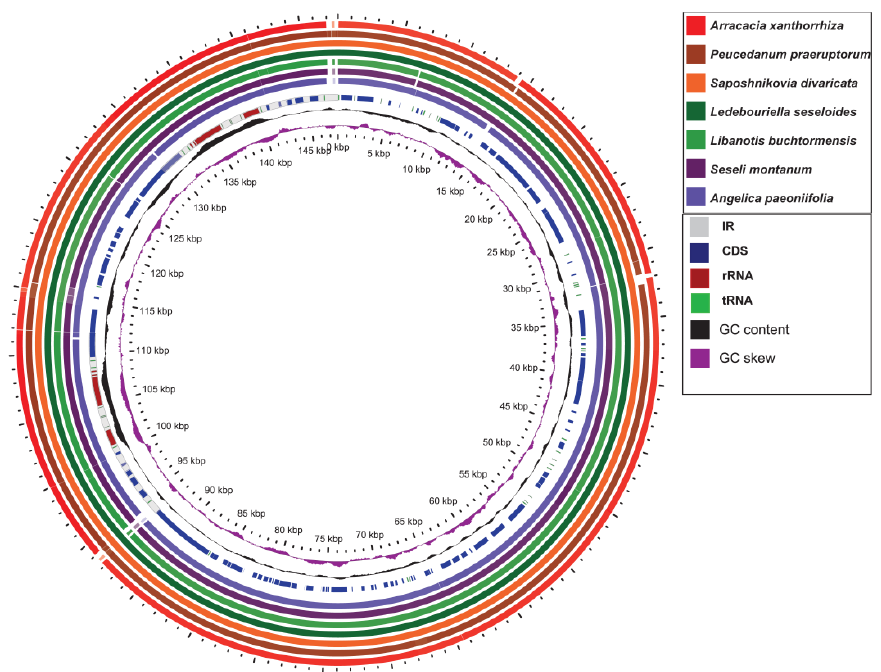
Figure 2. Comparison of GC content of the wild S. divaricata cpDNA using GView program. Table 1. List of genes found in the chloroplast genome of the wild S. divaricata . Group of